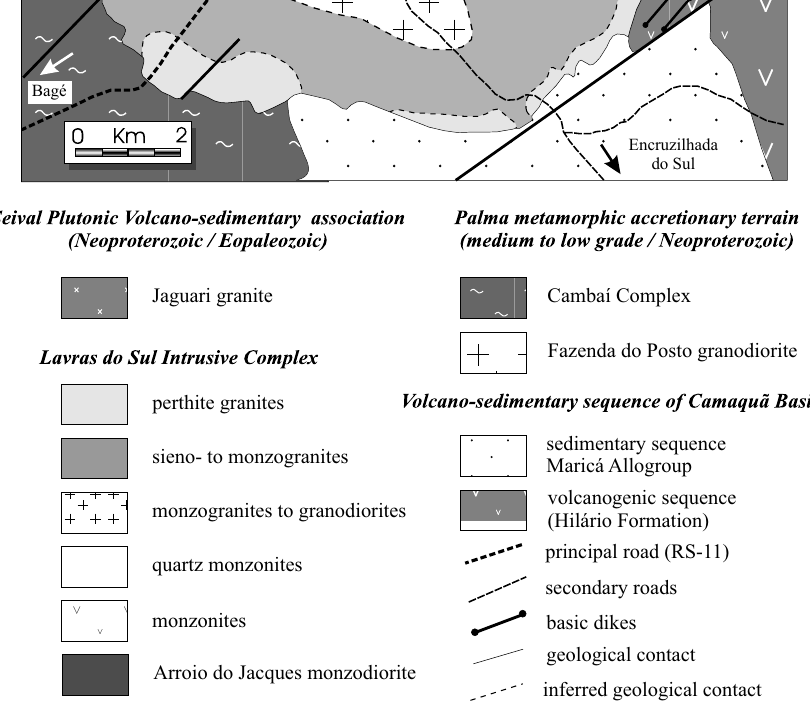
An Acad Bras Cienc (2005) 77